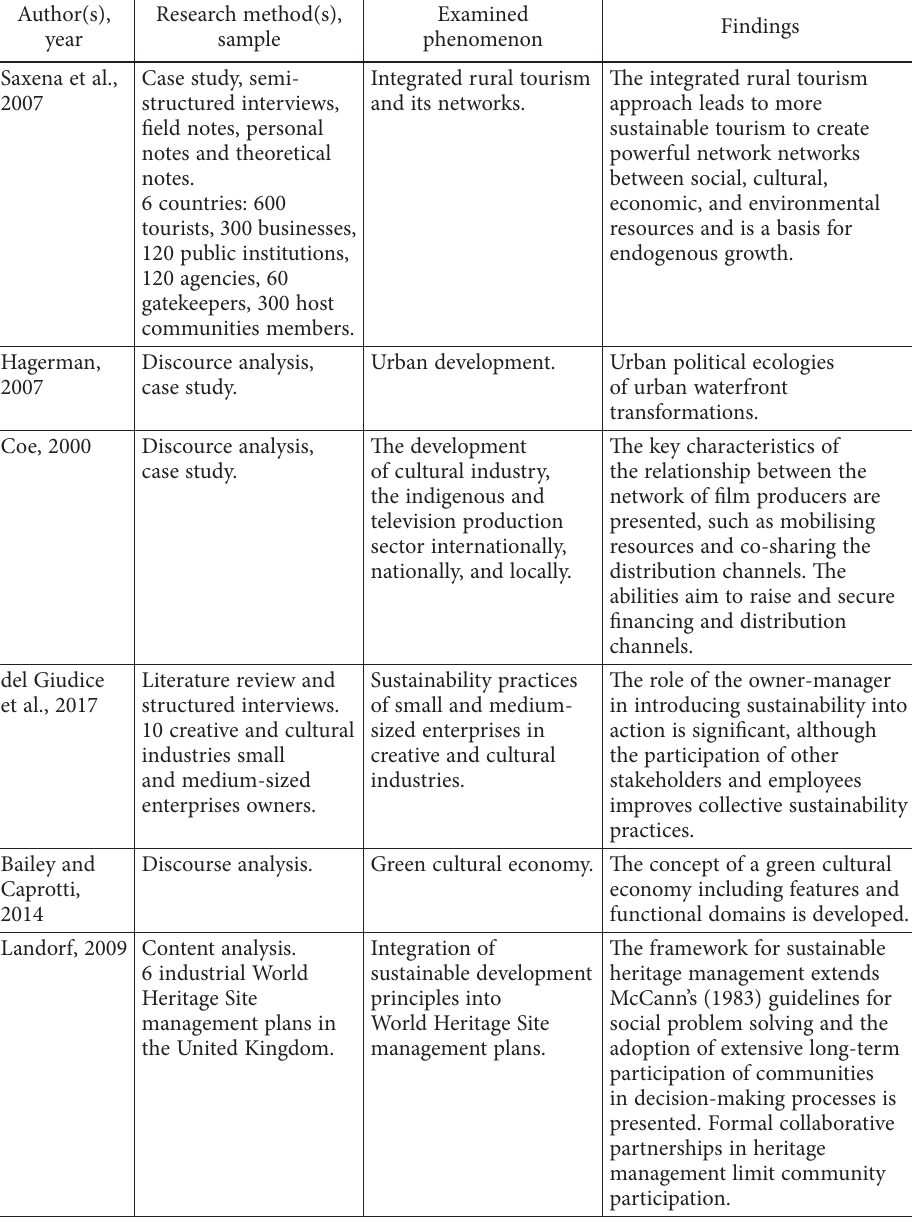
Table 4. Review of fifteen the most influential articles (source: created by the authors) Author(s),